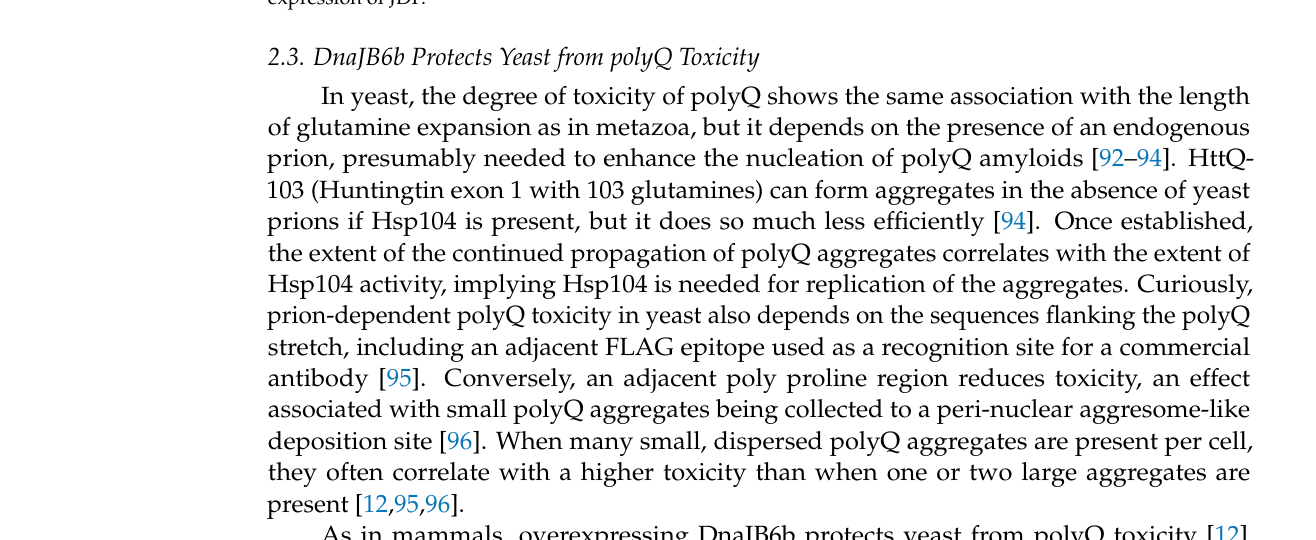
Table 1. Cont. JDP Amyloid Effects on Amyloid and Associated Toxicity c Ure2 Cures cells of [URE3] prions Ydj1 Htt-Q103 ↑ toxicity and size of polyQ aggregates in [ PIN + ] cells a Or DnaJB8. b Prion variants are weak ([ PSI + ] W ) and strong ( PSI + ] S ). c Upward-pointing arrows indicate